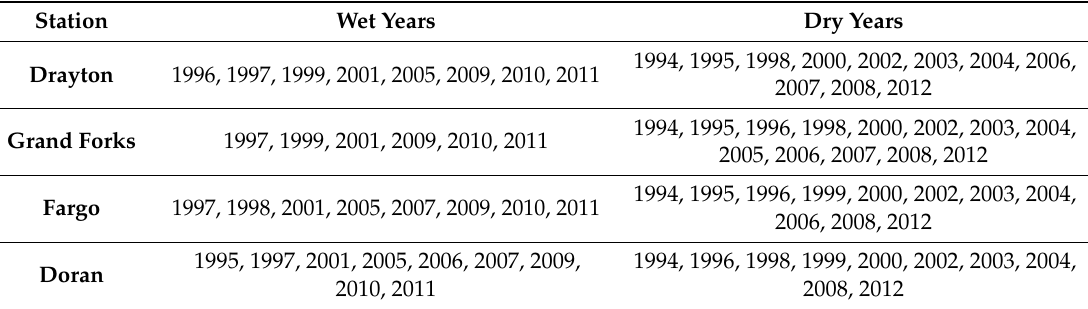
Table 1. Wet and dry years for four gauging stations along the Red